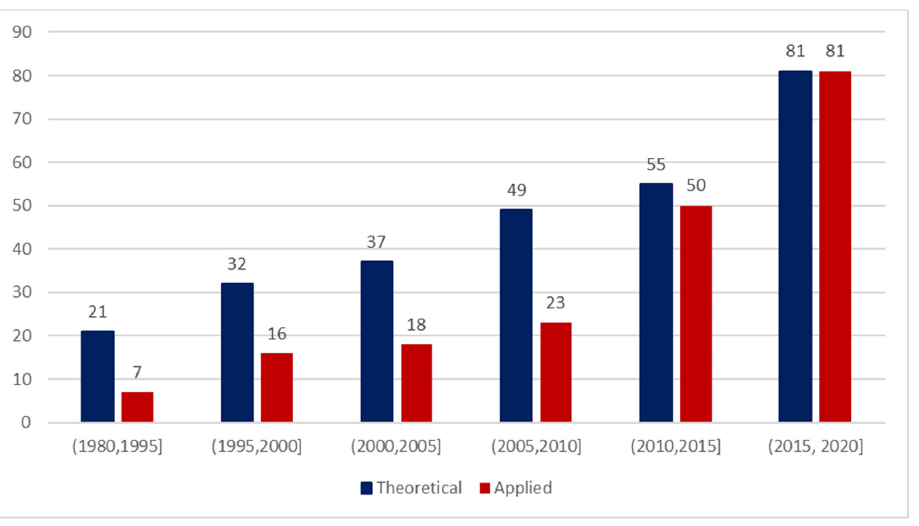
Figure 3. Classification of prior elicitation pertinent articles according to LDA topics and publication years.